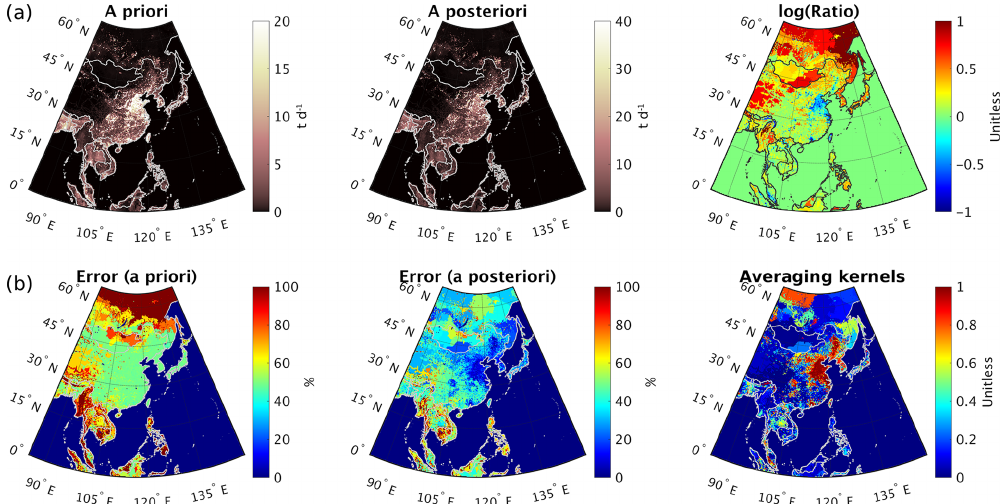
Figure 3. (a) Total NO x emissions (i.e., the a priori) constrained by the satellite observations (i.e., the a posteriori) in May–June 2016 and the natural logarithmic ratio of the a posteriori to the a priori. (b) The errors in the a priori based on Table 3, the errors in the top-down estimation, and the averaging kernels (AKs) obtained from the